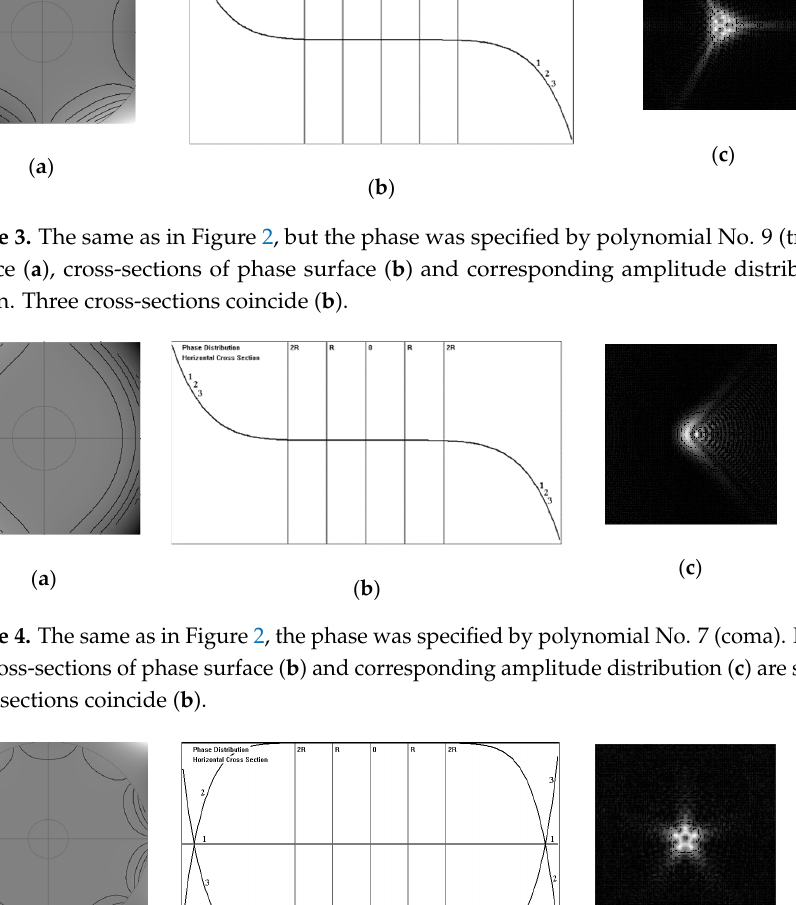
( c ) Figure 6. The same as in Figure 2, the phase was specified by the sum of polynomials from 1 to 6. Phase surface ( a ), cross-sections of phase surface ( b ) and corresponding amplitude distribution ( c ) are shown. ( а ) ( c ) Figure 7. The same as in Figure 2, the phase was specified by the sum of polynomials from 1 to 7. Phase surface ( a ), cross-sections of phase surface ( b ) and corresponding amplitude distribution ( c ) are shown. Registered distributions of singular points are presented in Figures 8 and 9, corre- sponding phase profiles were set by such polynomials as coma (Figure 8) and trefoil (Figure 9). To improve the reliability of results dislocations were localized by three algo- rithms built on different principles.